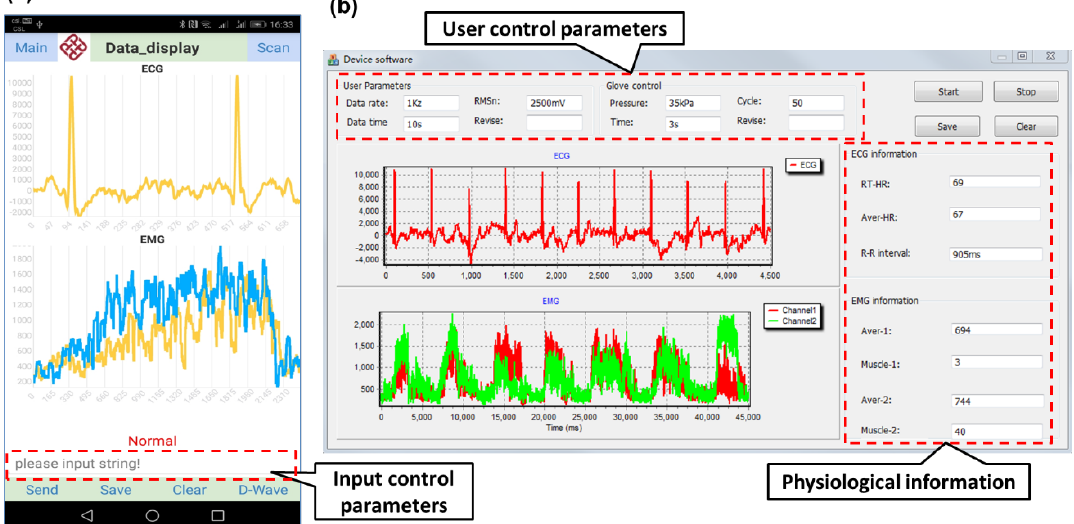
Figure 10. ECG / EMG monitoring software: ( a ) mobile interface for ECG / EMG monitoring (robotic Figure 10. ECG/EMG monitoring software: ( a ) mobile interface for ECG/EMG monitoring (robotic glove control use control parameters); ( b ) computer interface for ECG / EMG monitoring and robotic glove control use control parameters); ( b ) computer interface for ECG/EMG monitoring and robotic glove glove control.